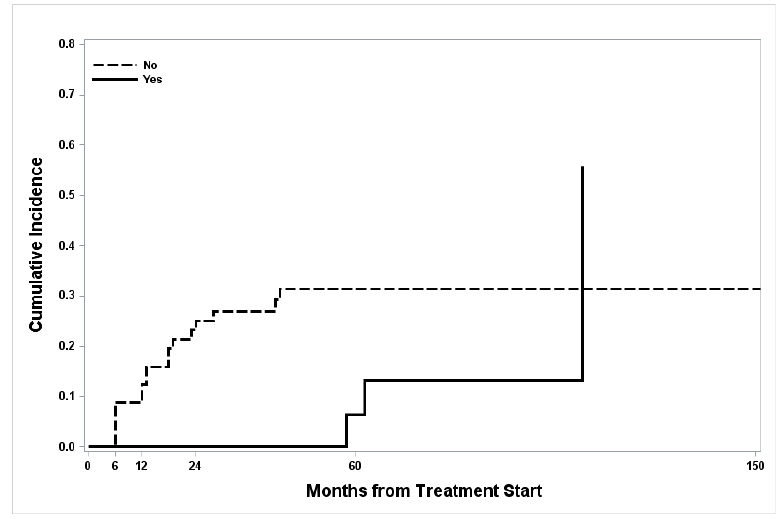
Figure 2. Cumulative incidence curves for relapse according to post-treatment pregnancy status. At Cox regression analysis, no factors significantly influenced hazard ratio (HR) for time to relapse (Table 3). Table 3. Cox regression Hazard Ratio (HR) estimates for time (months) to relapse.